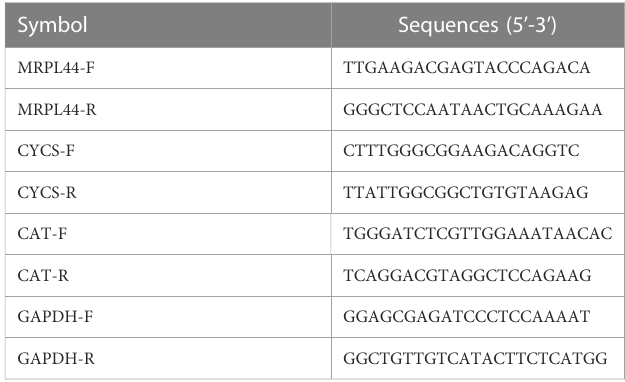
TABLE 1 The primer sequences in PCR